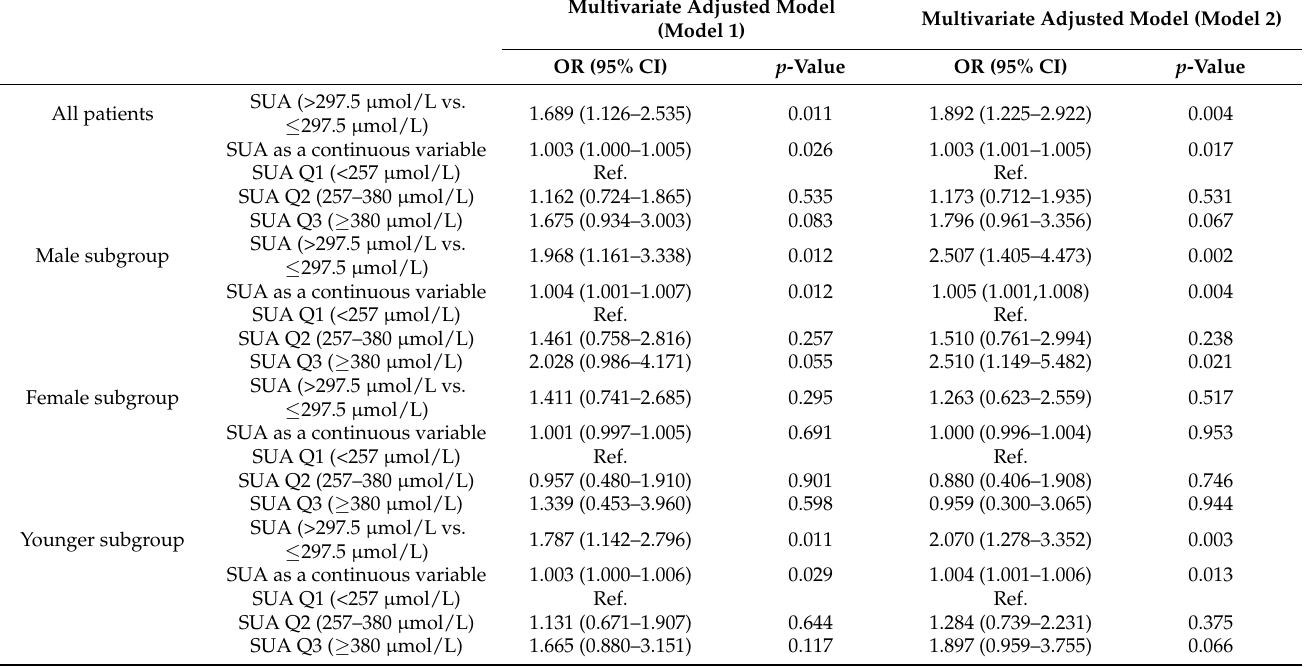
Table 3. Multivariate logistic regression analysis of the association between SUA and